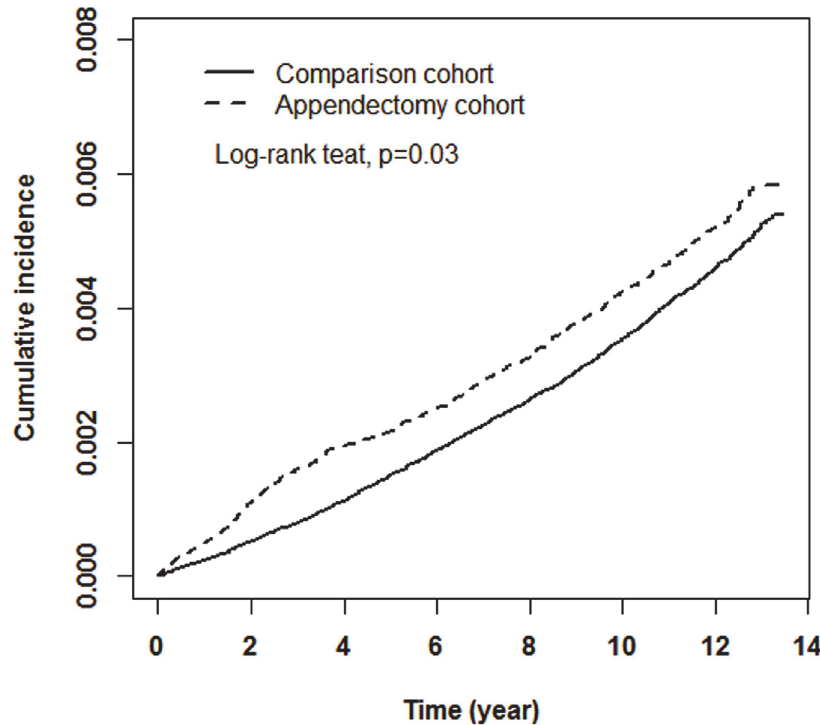
doi:10.1371/journal.pone.0118411.g002